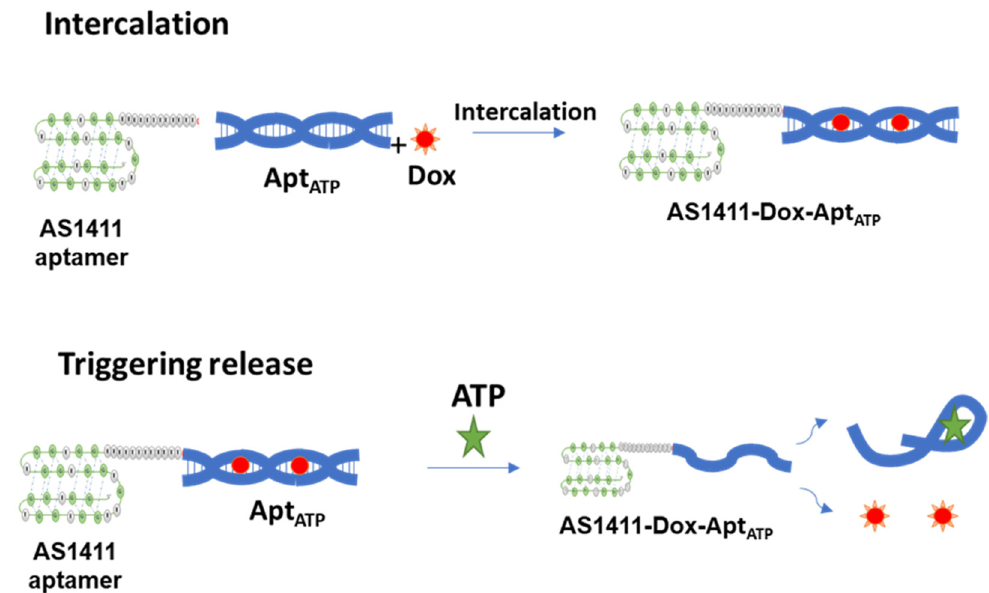
Figure 1. Design of the generated aptamer–aptamer chimera.